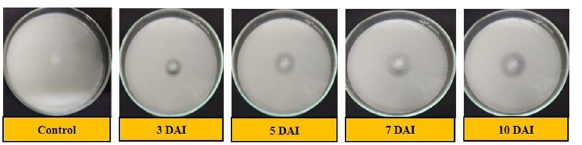
Figure 5. Solubilization of potash by isolate S 4 on 3, 5, 7 and 10 DAI